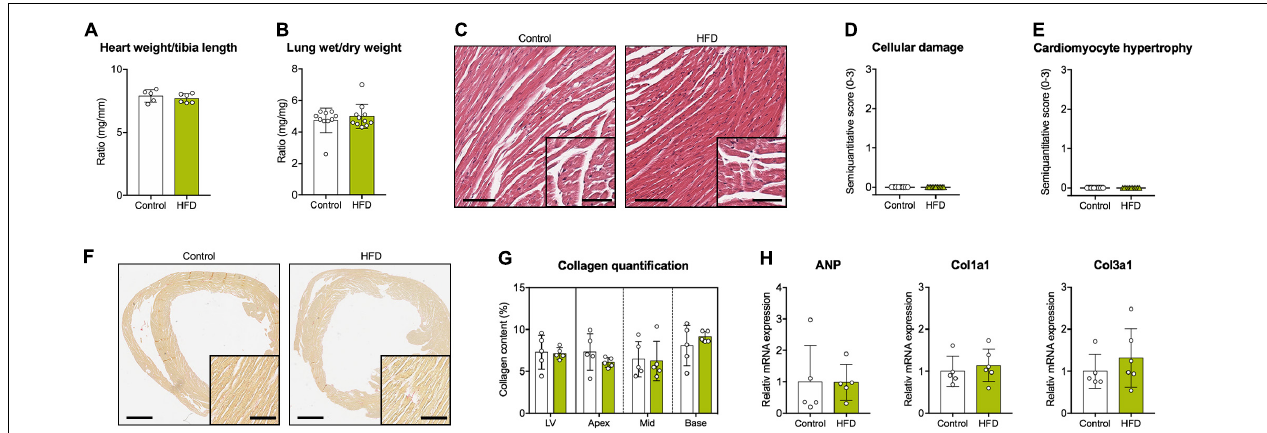
FIGURE 2 | Cardiovascular tissue analyses. (A) Heart weight normalized to tibia length. (B) Wet-to-dry lung weight ratio. (C) Representative cardiac cross sections stained with hematoxylin/eosin (scale bars = 100 µ m and 50 µ m, respectively). Semiquantitative histological scores for (D) cellular damage and (E) cardiomyocyte hypertrophy. (F) Representative cardiac cross sections stained with Picrosirius Red for the detection of collagen fibers (scale bars = 1 mm and 100 µ m, respectively). (G) Quantification of myocardial collagen content in the whole LV and the different myocardial segments. (H) Gene expression analysis of ANP , Col1a1 , and Col3a1 in myocardial tissue. ANP , atrial natriuretic peptide; Col1a1 , collagen type I alpha 1 chain; Col3a1 , collagen type III alpha 1 chain. Mean ± SD; n = 5–6 (A,G,H) and 10–11 (B,D,E) per group; unpaired Student’s t -test or Mann-Whitney U test (no significant differences were found).